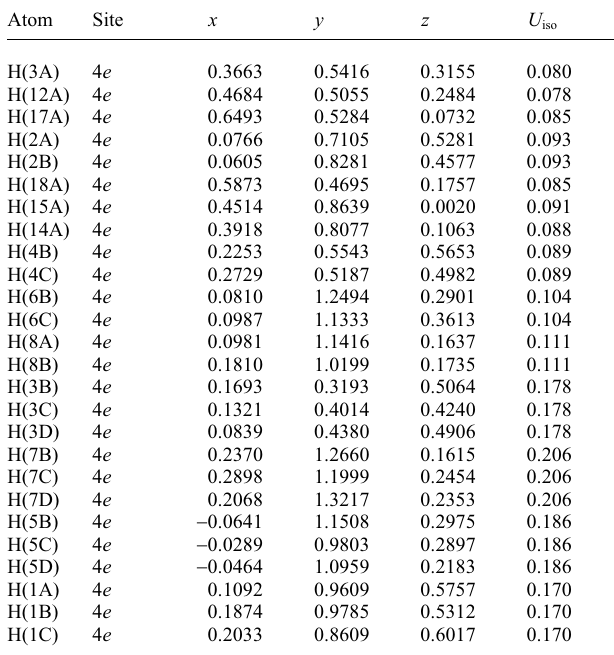
Table 2. Atomic coordinates and displacement parameters (in Å 2 ) .